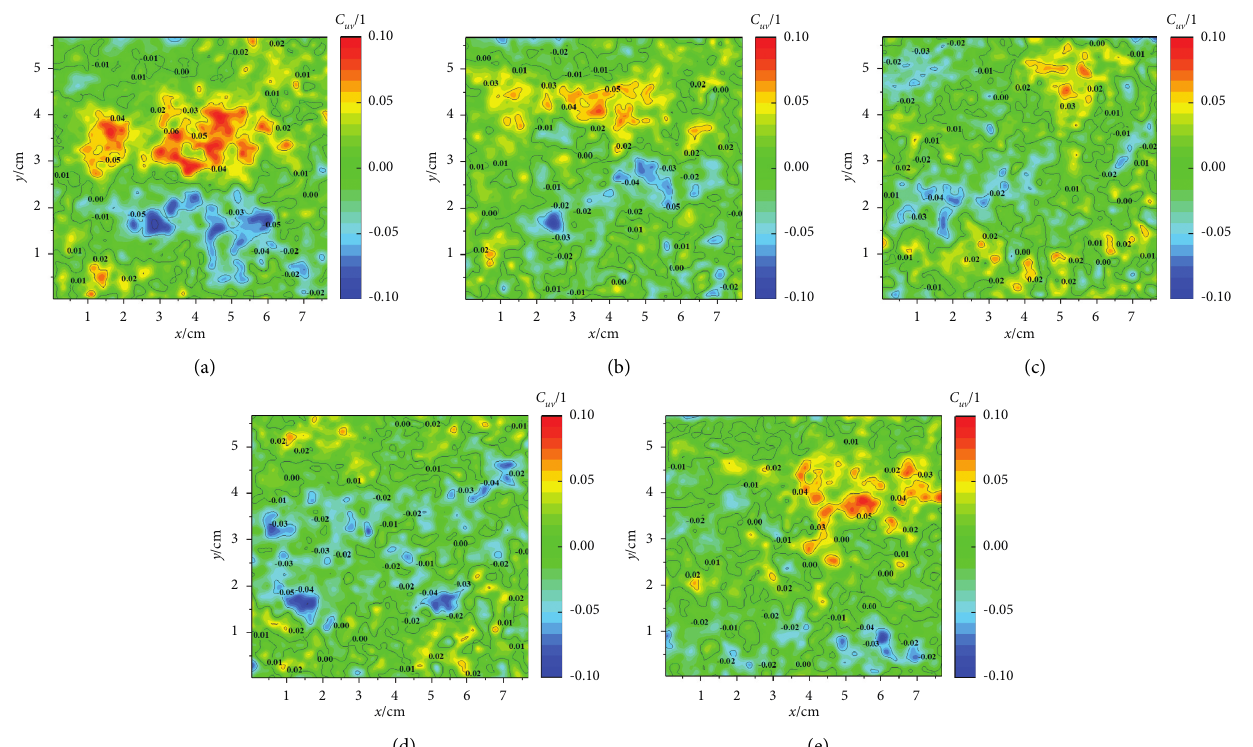
Figure 9: The distribution of C vu in different working conditions. (a) H25-1, (b) H25-1.2, (c) H25-1.5 (D252), (d) D251, and (e) D253.